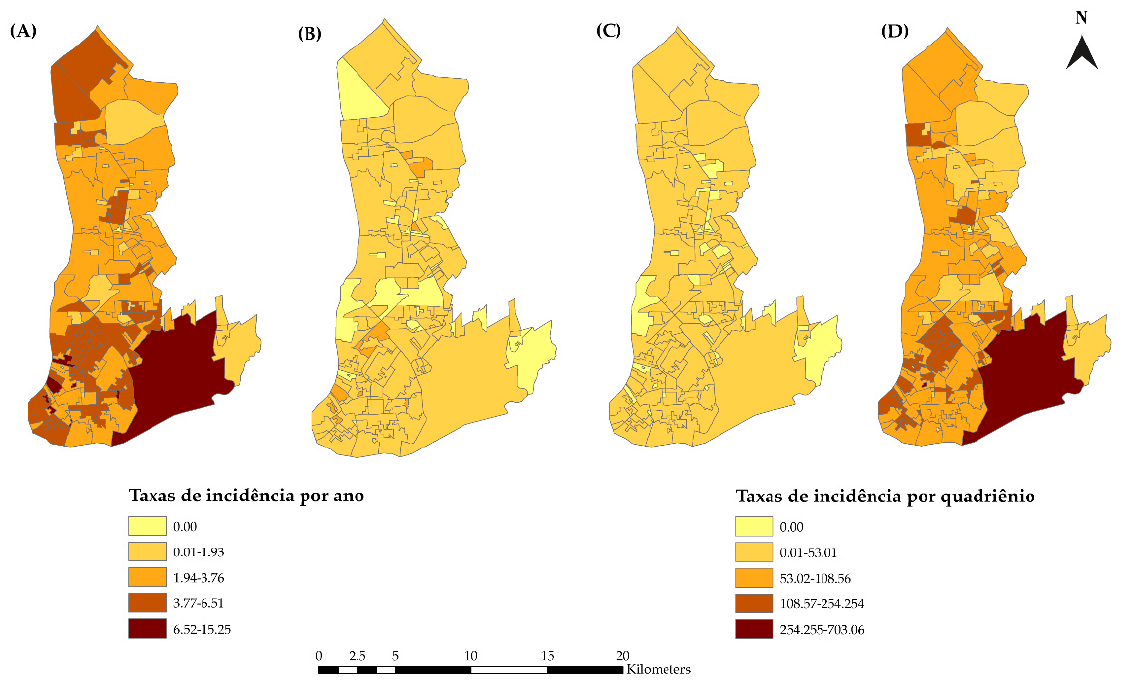
Figure 3. Map of the distribution of the standardized incidence rates of HIV infection and AIDS. ( A )